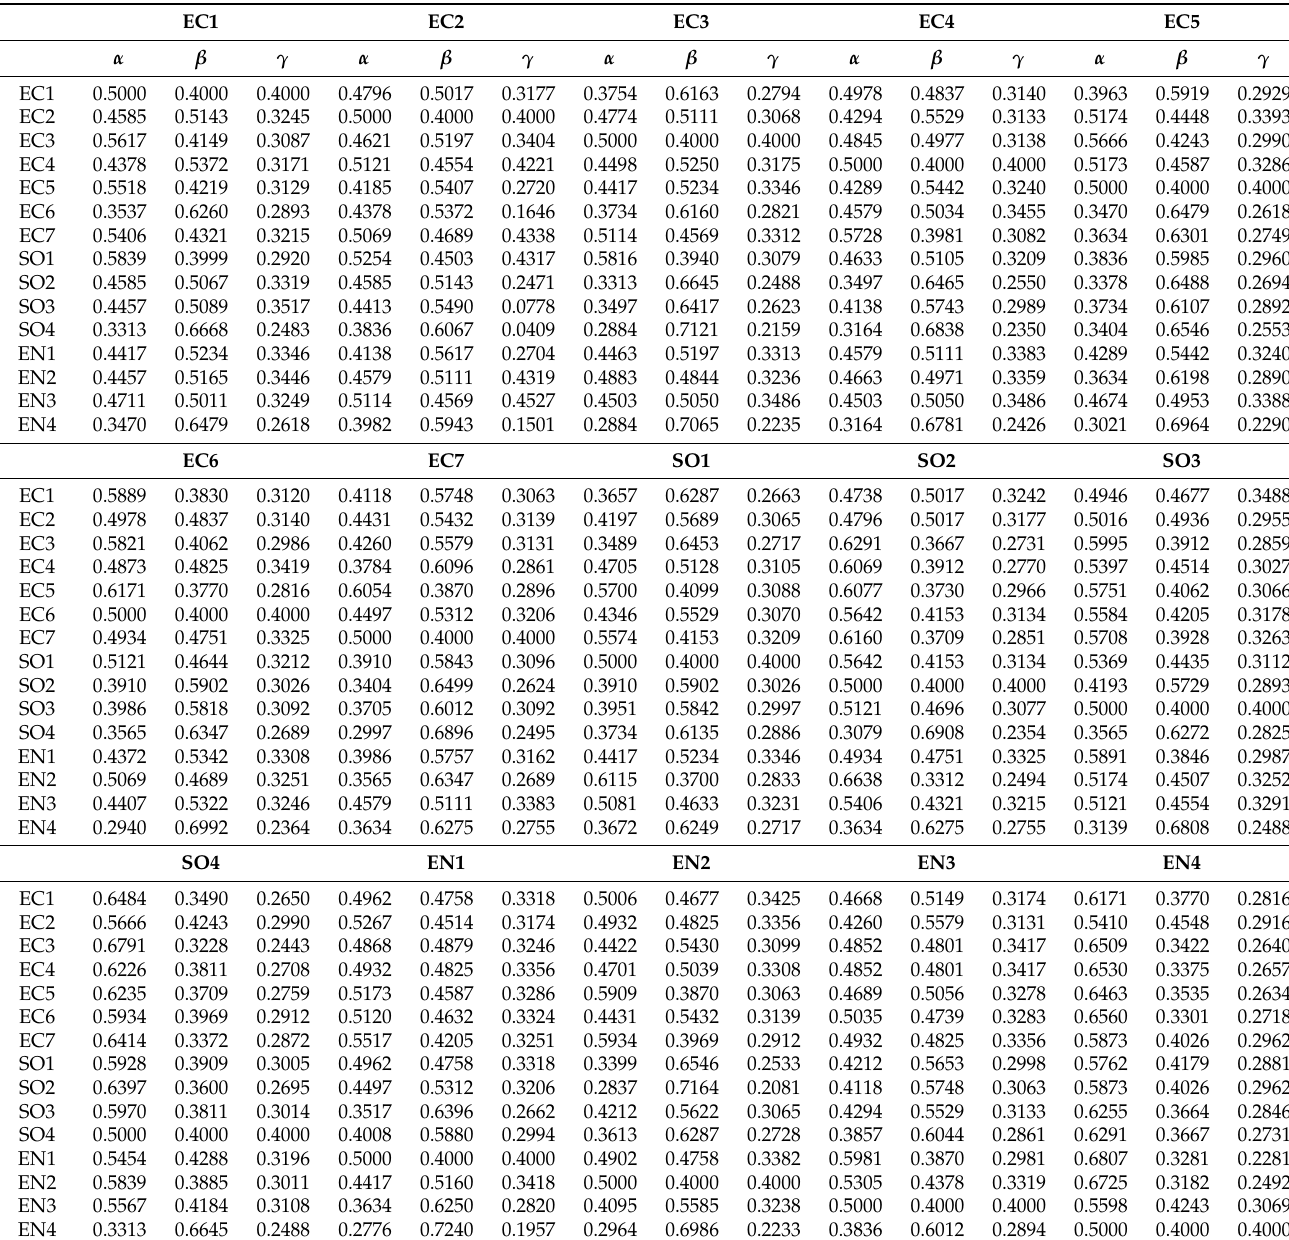
Table A1. The integrated SF-AHP comparison